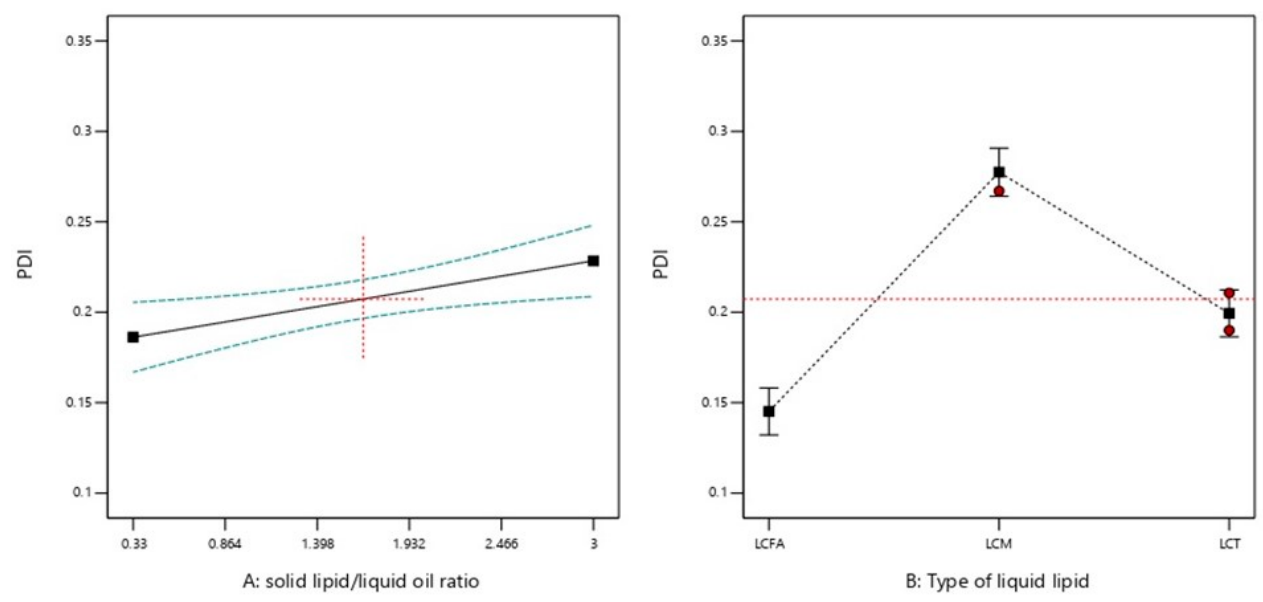
Figure 3. Graphical representation of the effects of ( A ) solid lipid: liquid oil ratio and ( B ) type of liquid oil on PDI. Red dotted horizontal line and plus sign represent the average value over factor B at the focused point of factor A = 1.665, respectively. Green dotted lines represent 95% CI bands. Red circles and black squares represent design points and predicted values, respectively.